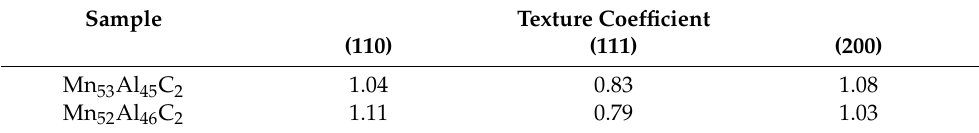
Table 2. Texture coefficient results for the samples annealed at 700 ◦